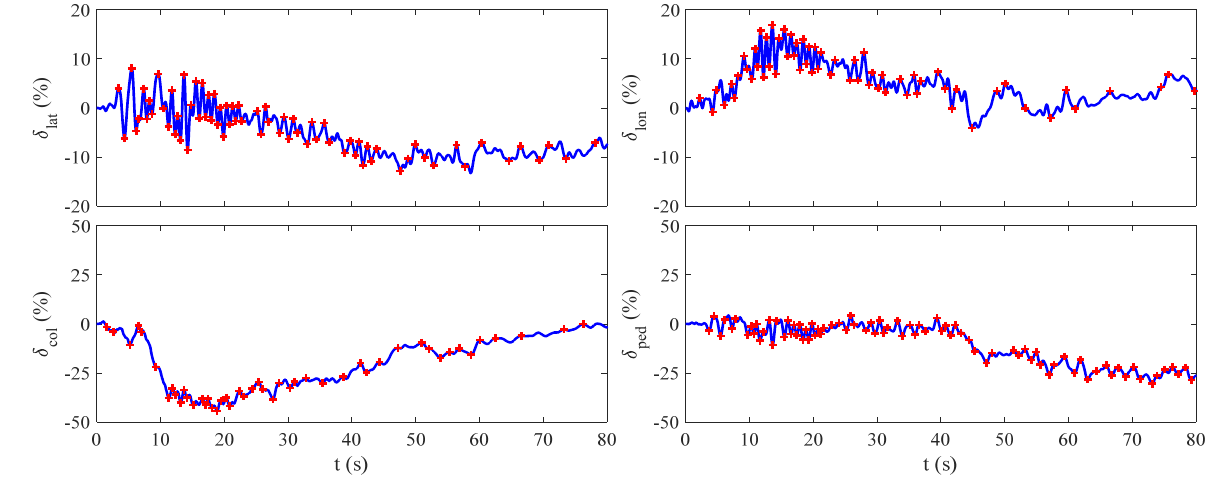
Figure 15. Time profiles of pilot controls for Case 1 with SAS off.